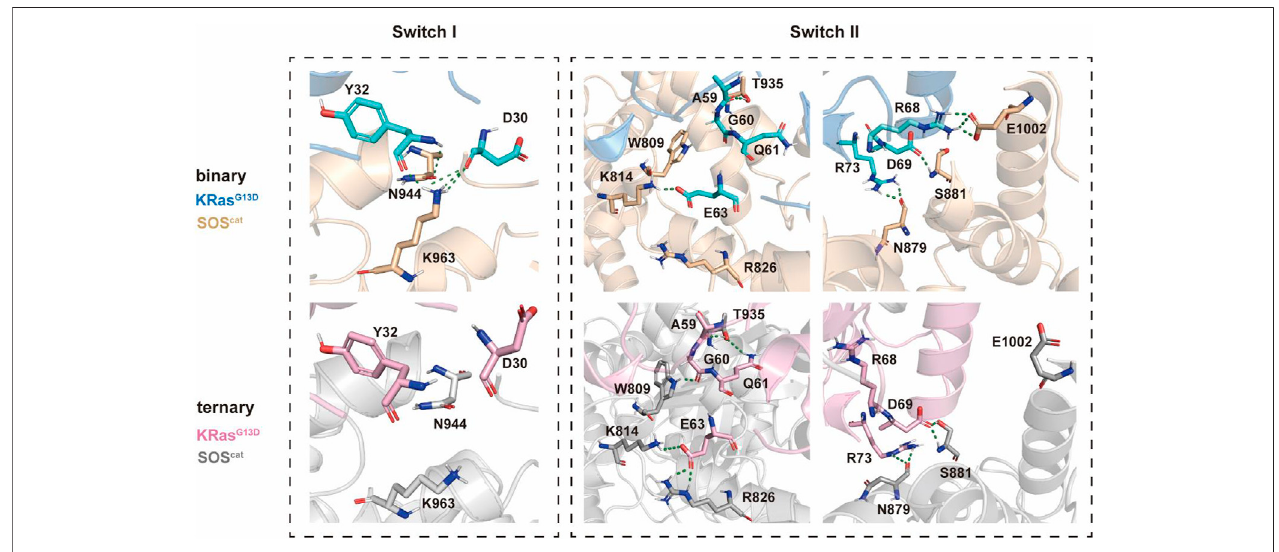
FIGURE 5 | Detailed interaction patterns between K-Ras4B G13D and SOS cat interfacial residues. Hydrogen bonds are marked with green dotted